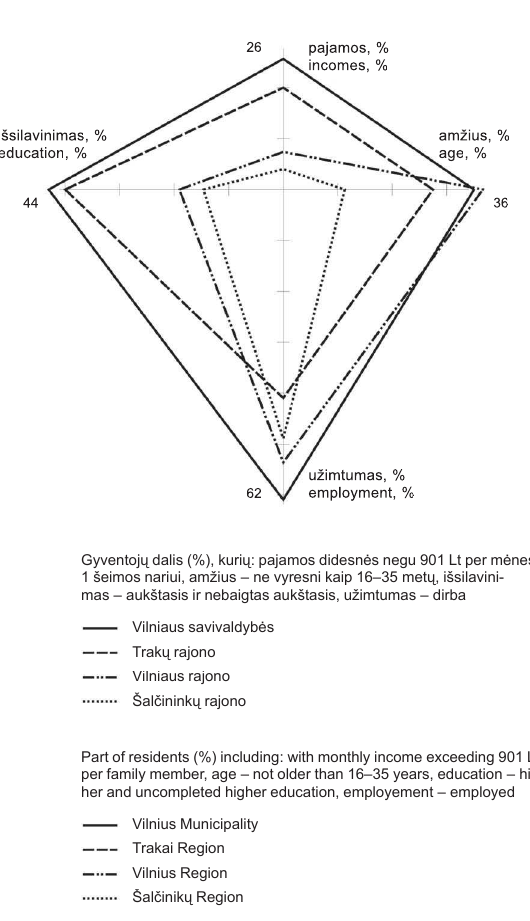
Fig 3 . Comparison of social demographic structures of Vilnius metro- polis residents